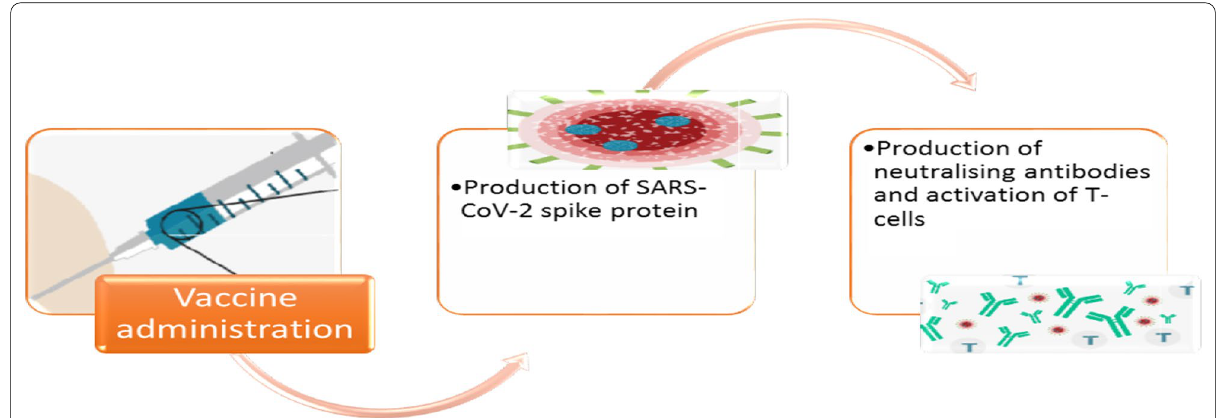
Fig. 1 COVID-19 vaccine activation of immune